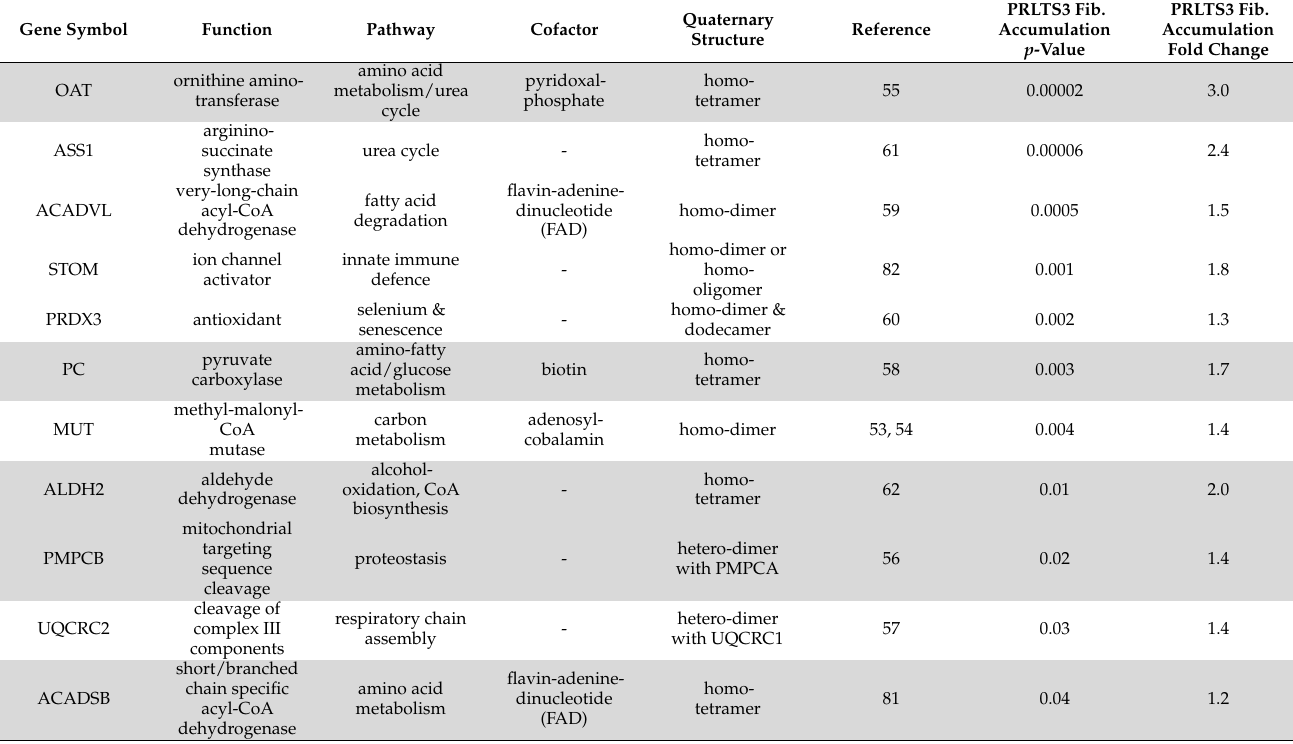
Table 2. Significant accumulations of the above eleven mitochondrial matrix proteins were consistent between both PRLTS3 fibroblasts and ClpP-null MEFs, and partially consistent with ClpP-null brains (highlighted by gray background), although they are not known as interactors of ClpX or ClpB. All of them show a multimerized quaternary structure, and they partly associate with